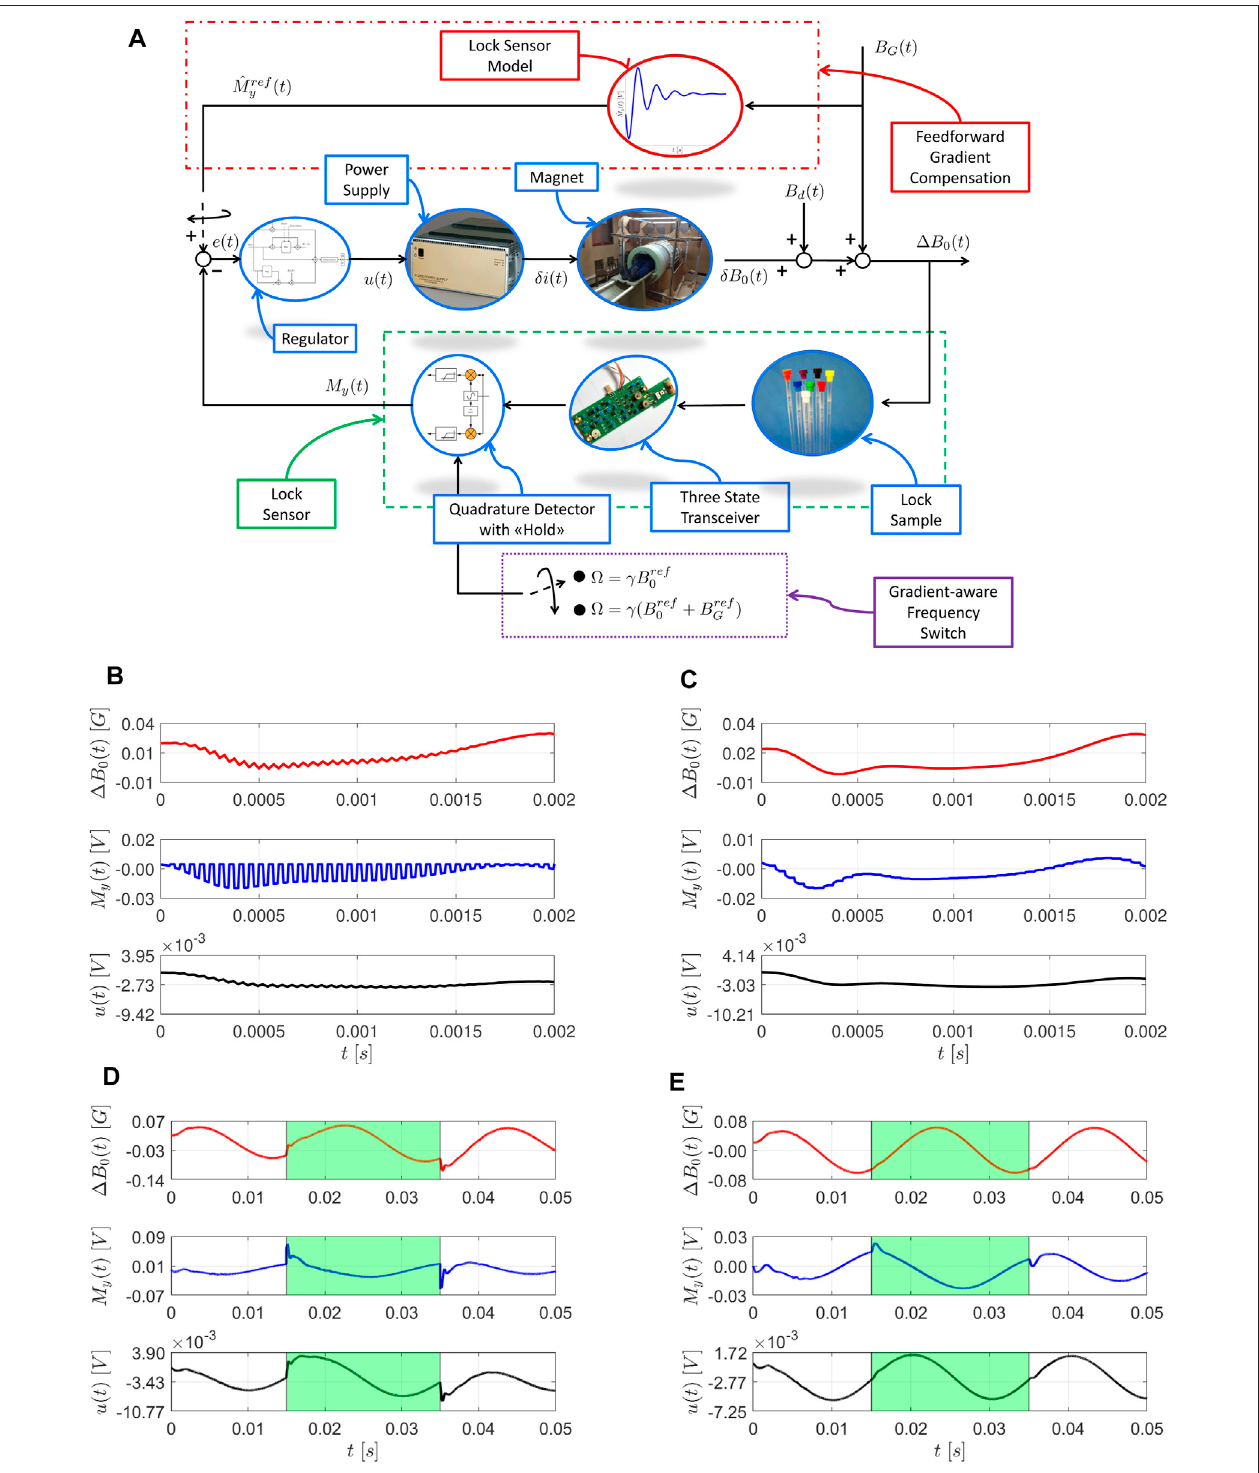
FIGURE 1 | Enhanced FFL control scheme for MRI and preliminary closed-loop simulations. Simulations are performed with a virtual version of the Copper Sulfate sample from [25]. (A) The control loop, including power supply, magnet, lock sample, three state transceiver, quadrature detector with hold procedure and a linear regulator. The cascade sample-transceiver-detectorplays the roleoflock magnetic fi eldsensor(green,dashed box). Themain signals inthe loopare thevoltage control action u ( t ) , the current correction δ i ( t ) , the magnetic fi eld correction δ B 0 ( t ) , the magnetic fi eld disturbance Δ B d ( t ) , the overall magnetic fi eld deviation Δ B 0 ( t ) , the